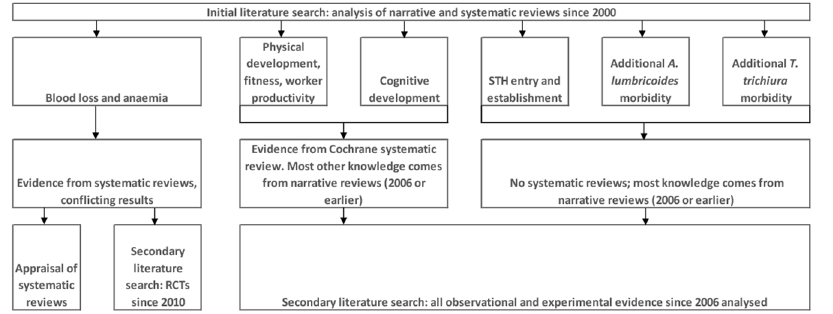
Fig 1. Literature selection flow